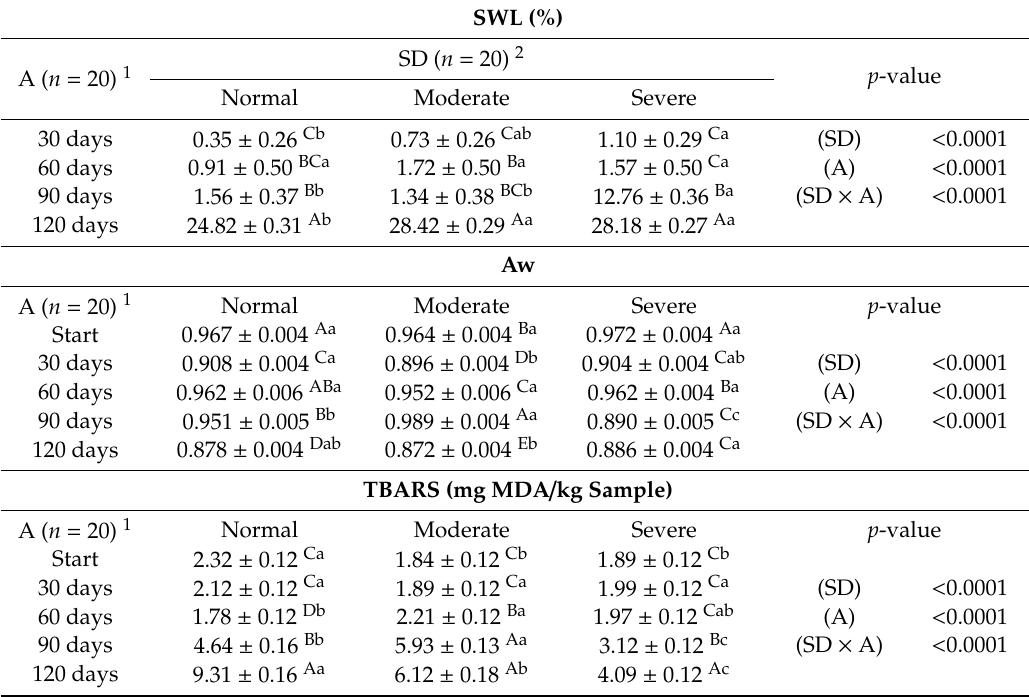
Table 4. Mean values of storage weight loss (SWL), water activity (A w ) and lipid oxidation (TBARS) in hamburgers produced from Ross broiler chicken (AP95) without myopathies and a ff ected by wooden breast myopathy after di ff erent storage periods.